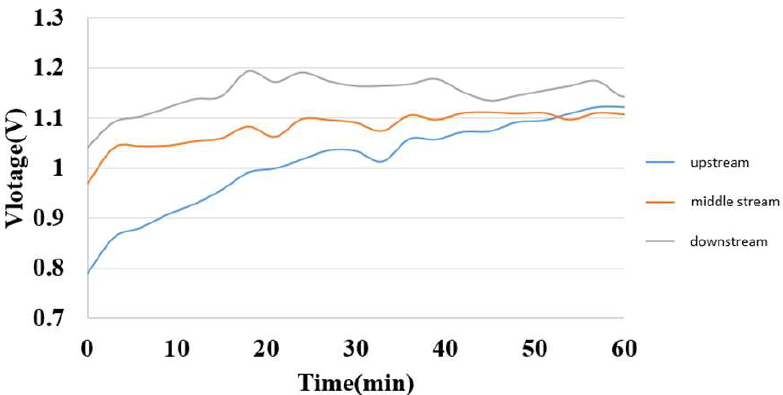
Figure 16. Internal voltage distribution during charging of hydrogen/vanadium liquid flow.